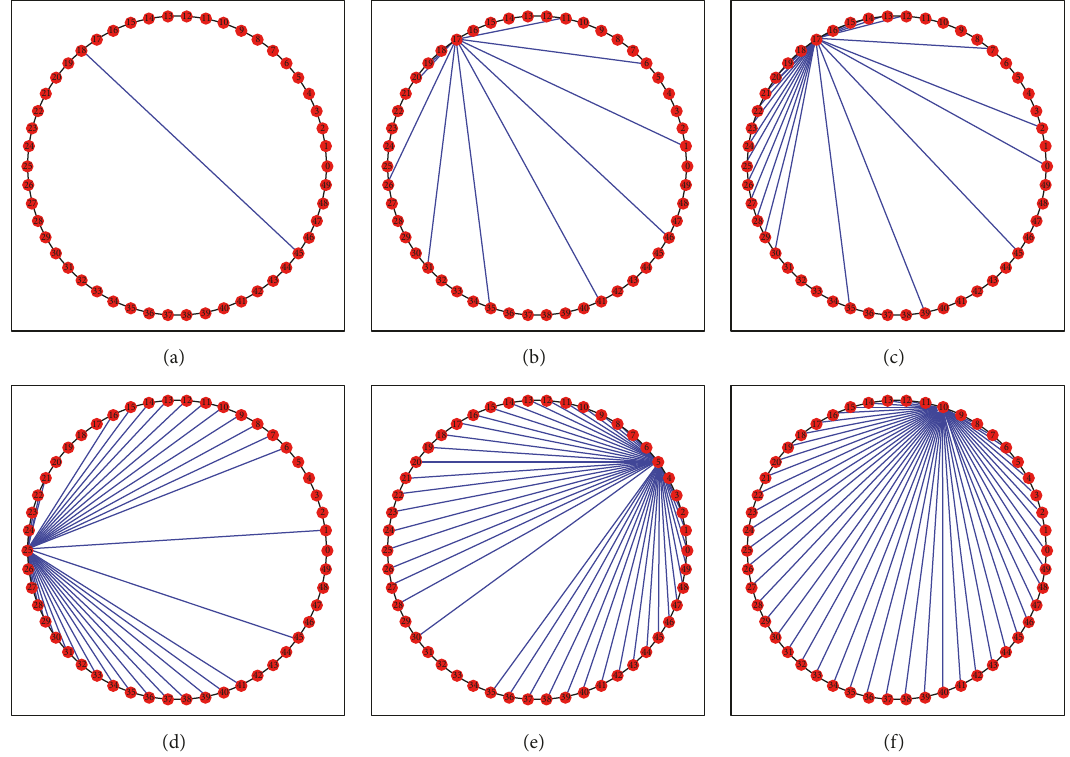
Figure 7: Optimizing results for improving efficiency of transforming a regular network into a small-world network. The figures show the topological structureof the GSA algorithm for adding edges. (a)shows thetopology of the original regularnetwork. (b)–(f) showthetopology as k edges are added ( k = 10, 20, 30, 40,